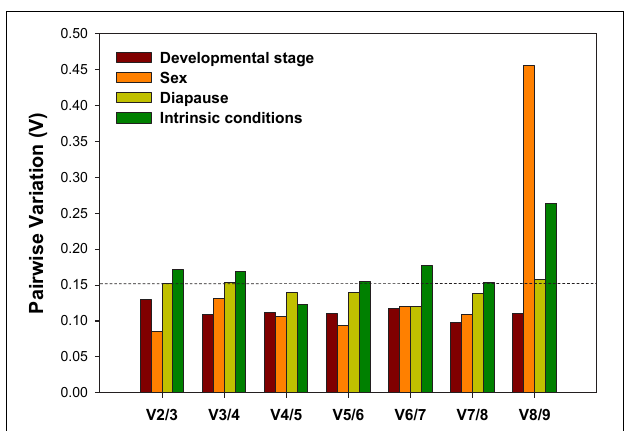
FIGURE 4 | Optimal number of reference genes for the normalization of A. viennensi gene expression under different intrinsic conditions. The pairwise variation (Vn/Vn + 1) was analyzed for the normalization factors by geNorm program to determine the optimal number of reference genes included in the RT-qPCR analysis. Values less than 0.15 suggest that the addition of another reference gene will not significantly improve the normalization.